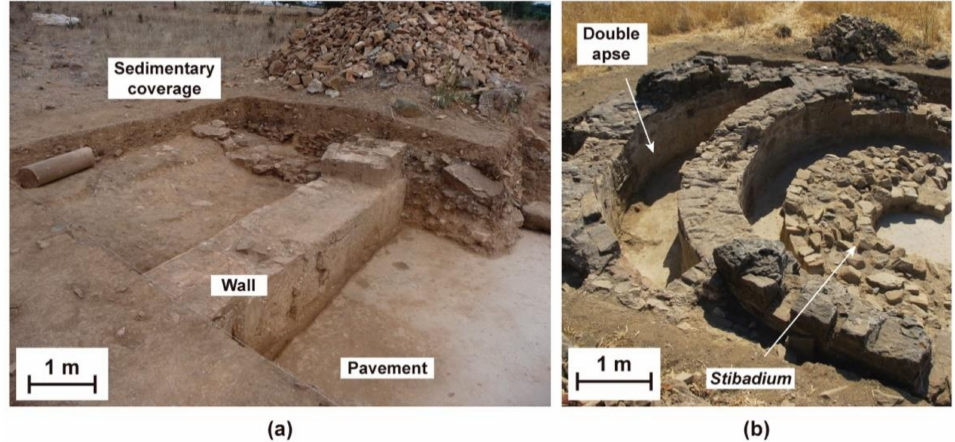
Figure 2. ( a ) Wall and pavement excavated after the 2013 GPR survey. ( b ) Double apse and stibadium remain. All the unearthed traces show great grandeur and robustness.